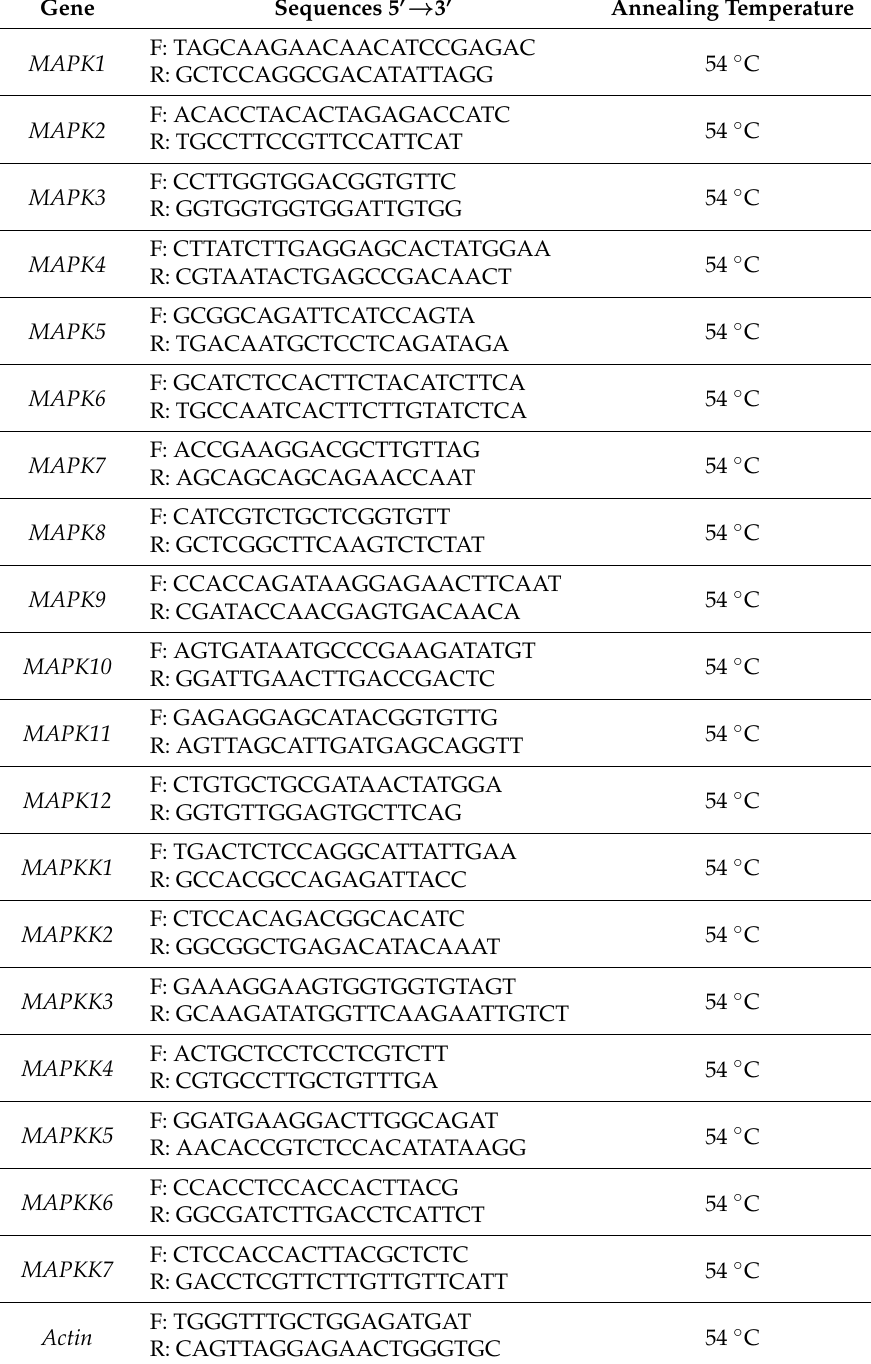
Table 2. Primer sequence